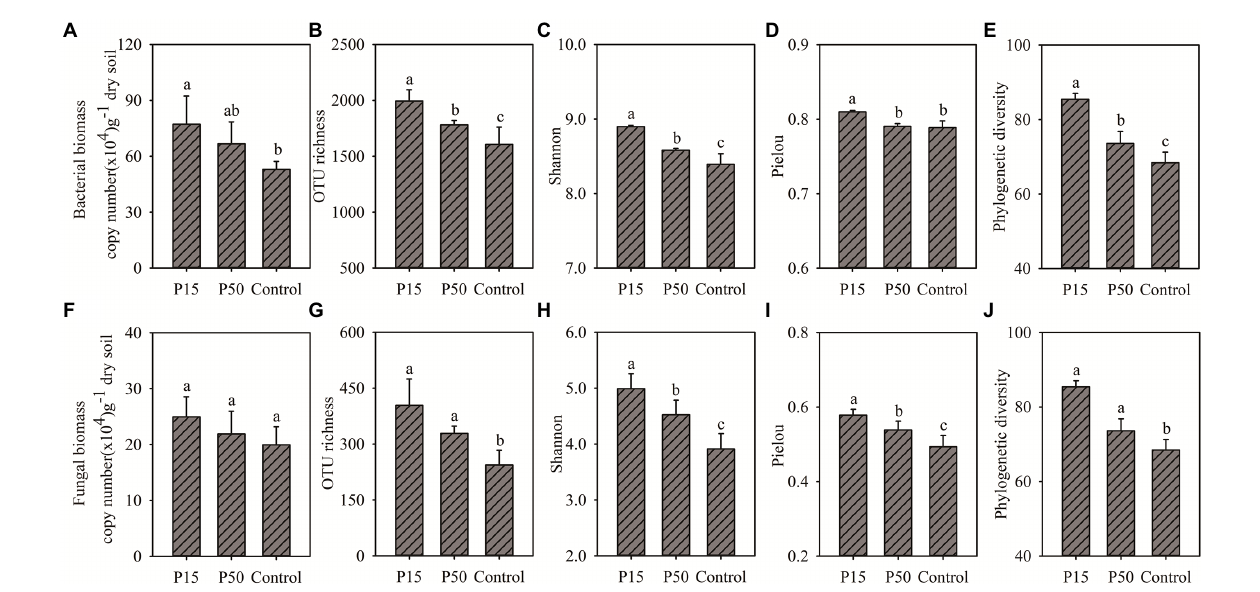
(Supplementary Figure S2). Significantly differentiated fungal genera between treatments were also analyzed (Supplementary Figure S3).